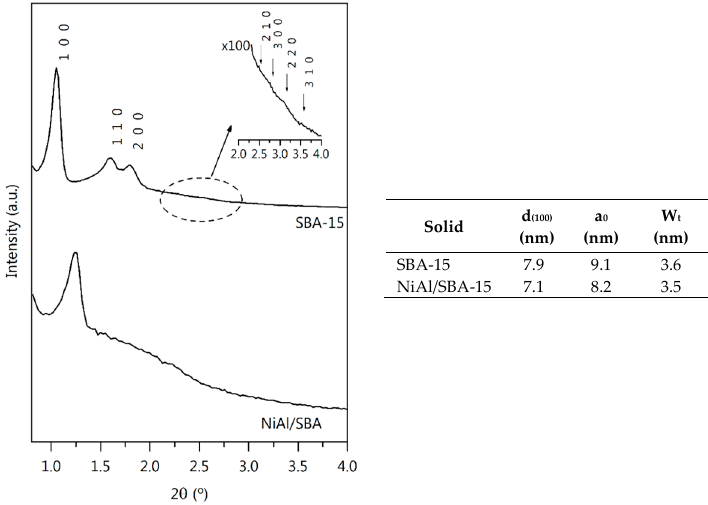
Figure 2. Low ‐ angle XRD diffractogram for calcined forms of SBA ‐ 15 and NiAl/SBA ‐ 15. In the table, Figure 2. Low-angle XRD diffractogram for calcined forms of SBA-15 and NiAl/SBA-15. In the table, d ‐ spacing, lattice parameter and wall thickness. d-spacing, lattice parameter and wall